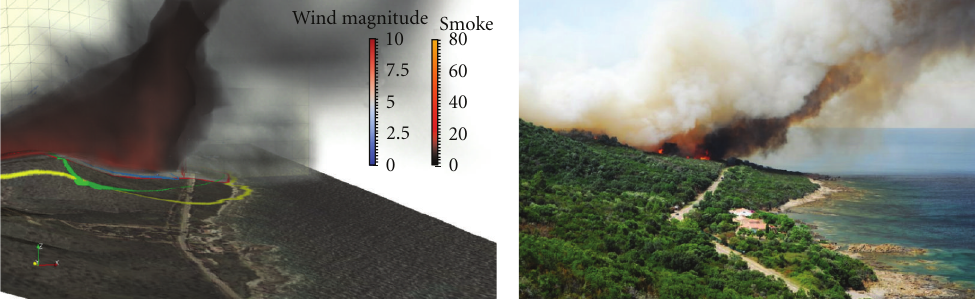
Figure 12: Case 2: Simulated and observed plume. Simulated plume is given 50 minutes after ignition (the blue contour represents the fire front at that time) with observation taken approximately at the same time.